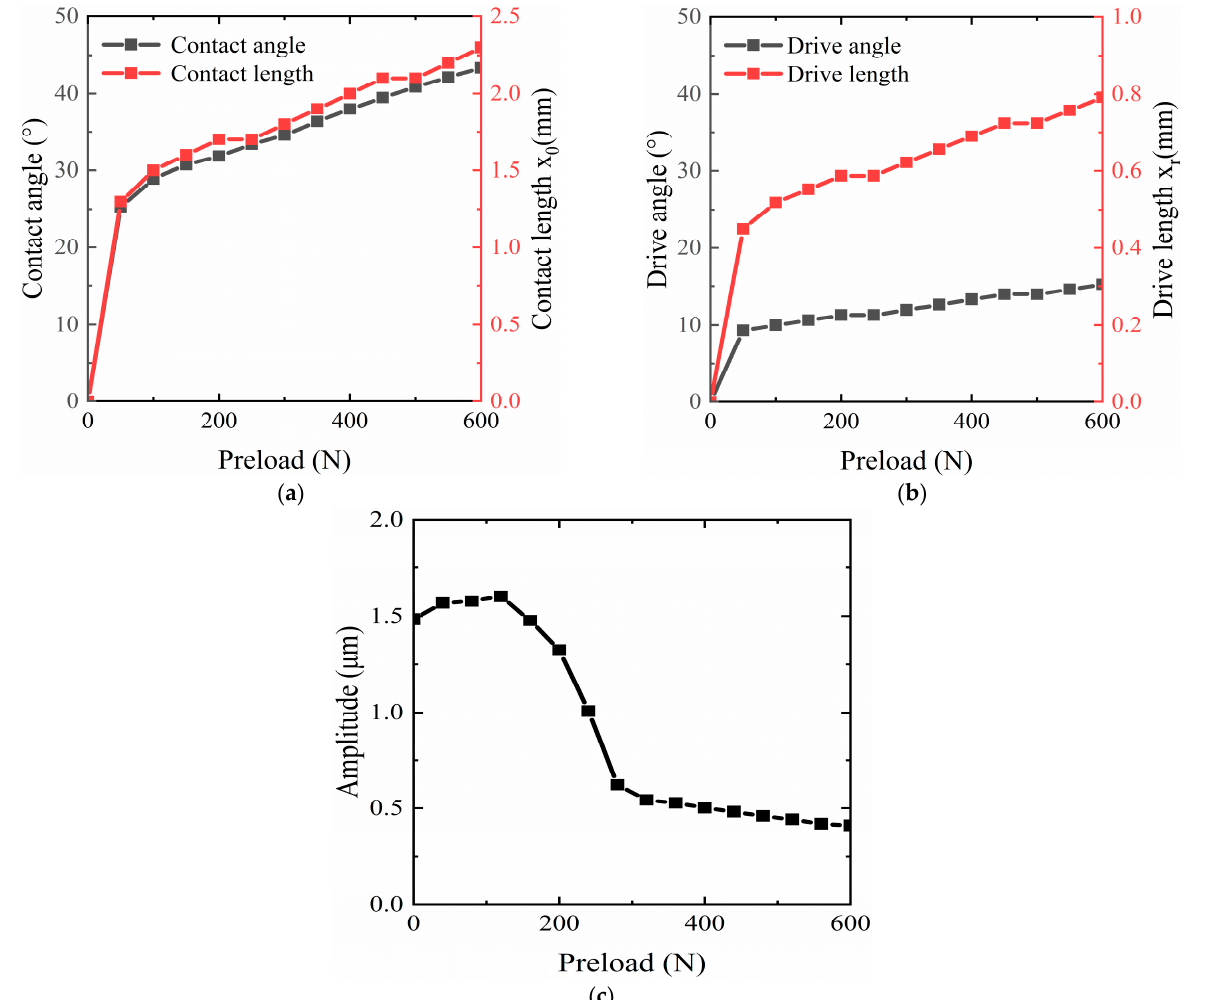
Figure 7. Contact interface parameters for no-load conditions at different preloads: ( a ) Contact length and contact angle; ( b ) Drive length and drive angle; ( c ) Amplitude.